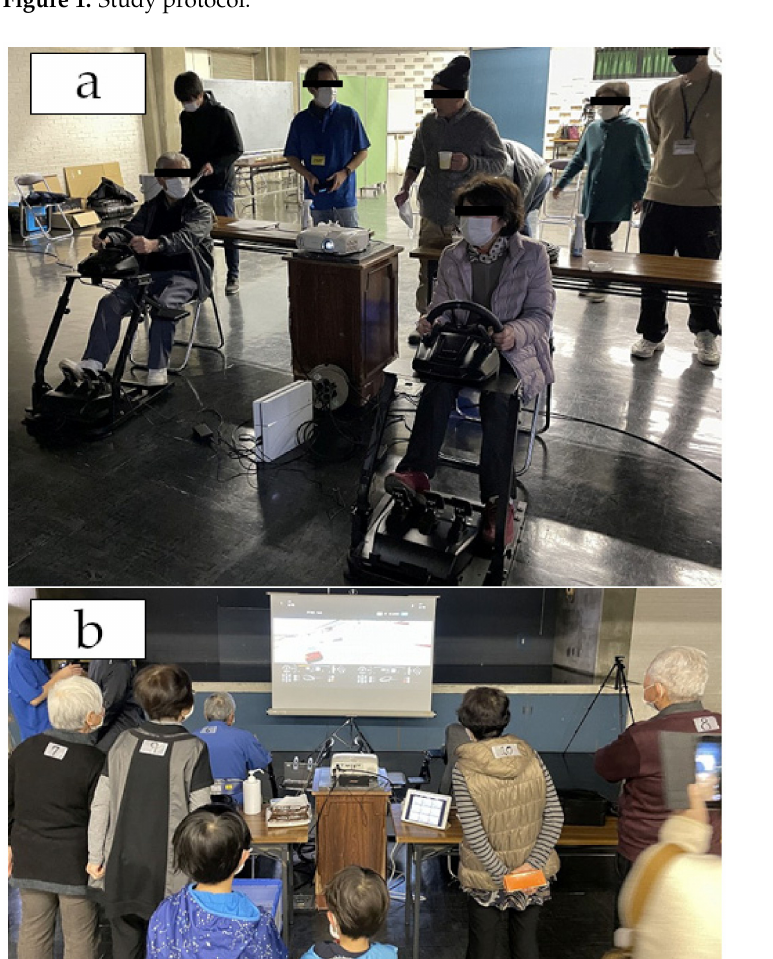
Figure 2. ( a , b ) Participants playing the